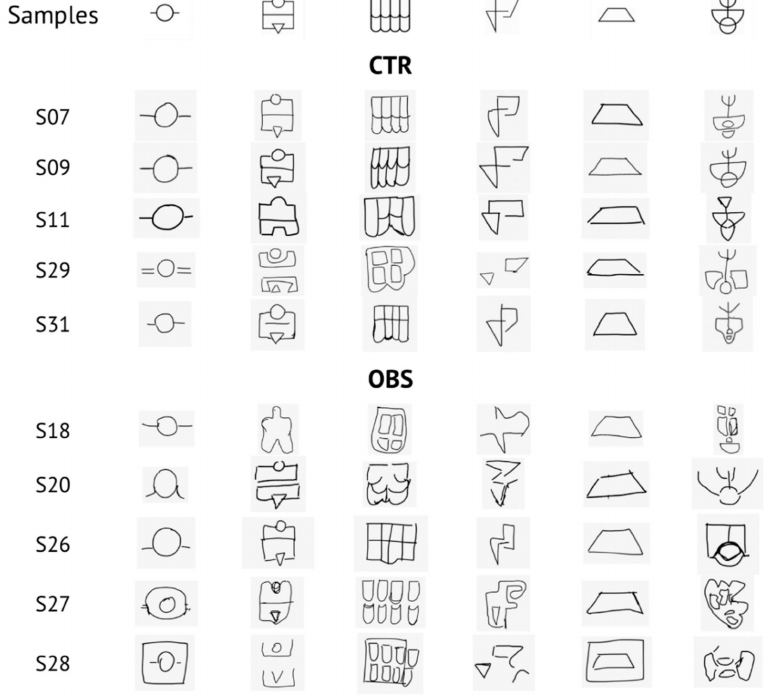
Figure 4. Samples of reproductions in the control (CTR) and obese (OBS) groups (five examples each). In the first line, the six original stimulus items are